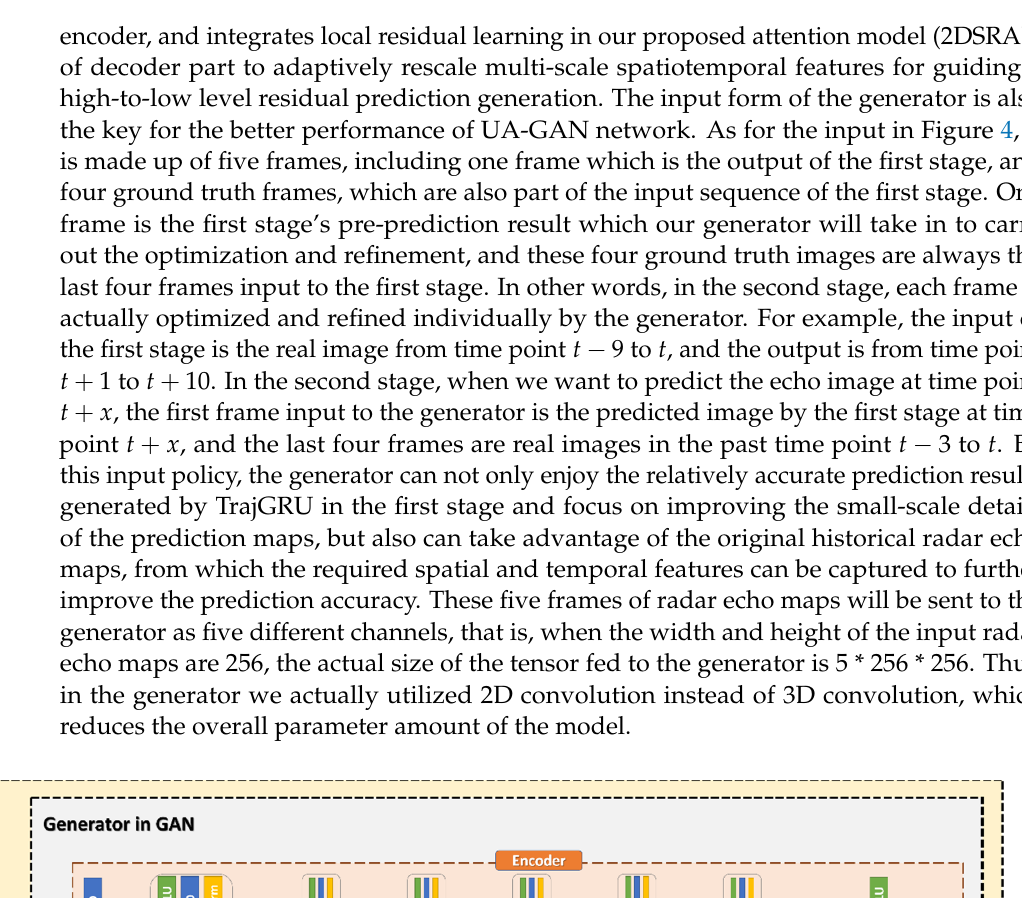
Table 3. Encoder part of generator used in UA-GAN (Stage 2).